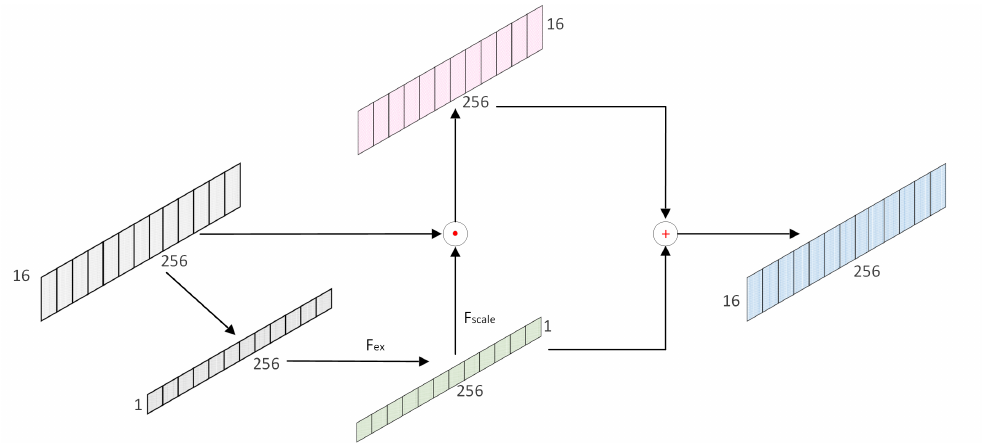
Figure 6. The detail of the channel attention block.